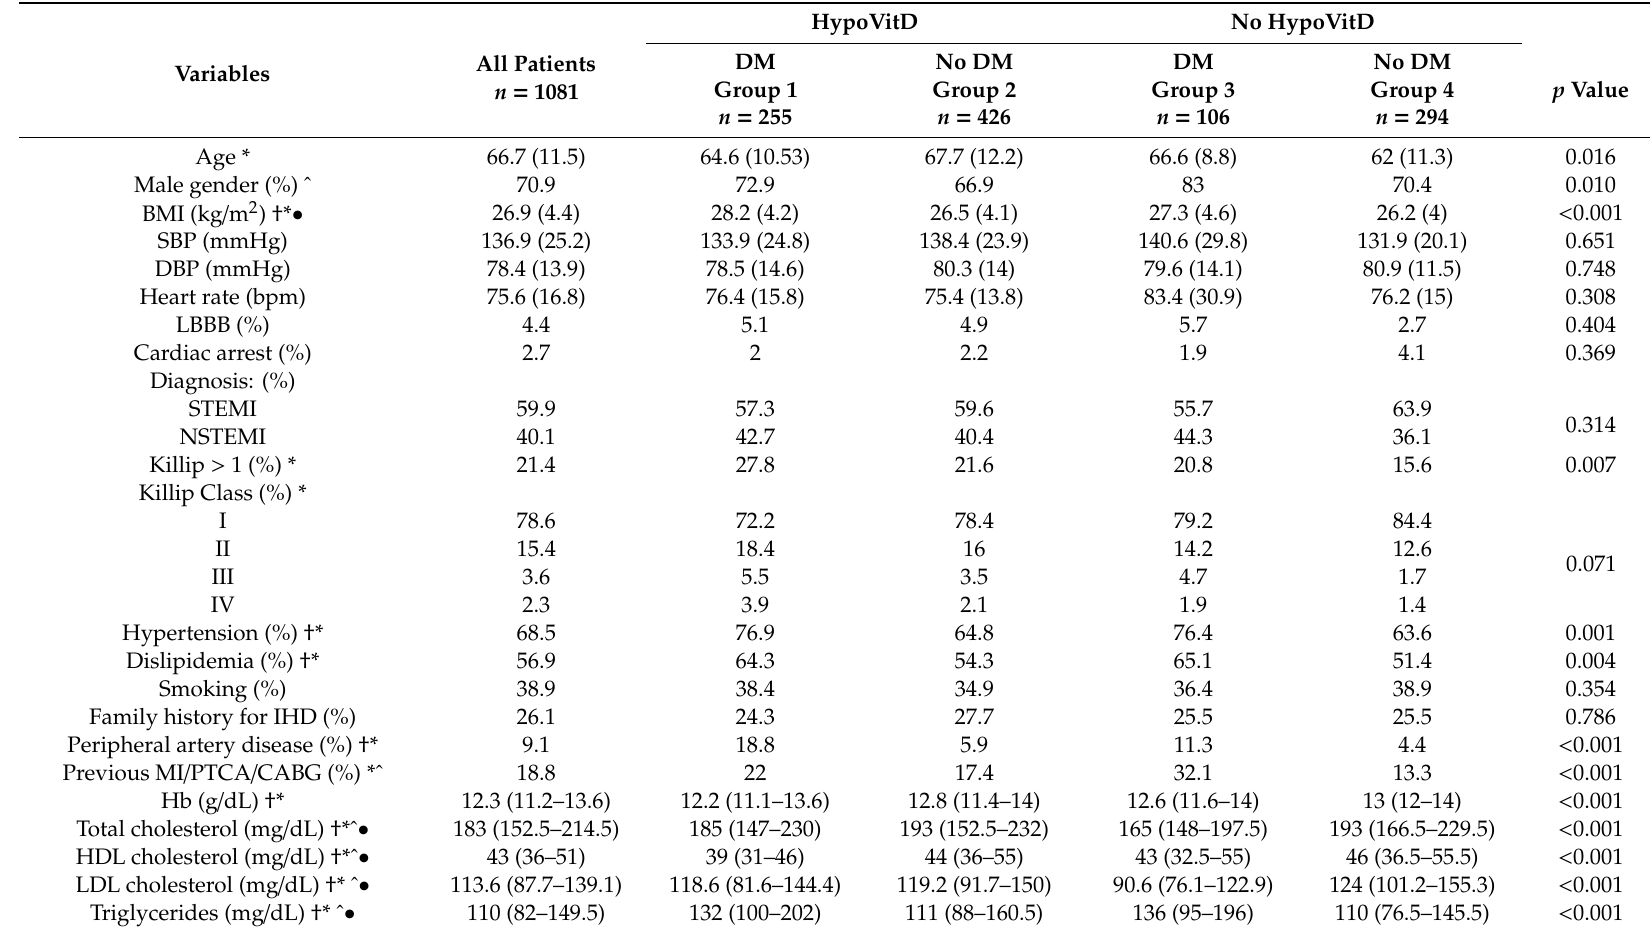
Table 1. Clinical characteristics of the study population according to diabetes and Vitamin D status: group 1 with diabetes mellitus (DM) and hypovitaminosis D, group 2 with only hypovitaminosis D, group 3 with only DM, and group 4 patients without DM and hypovitaminosis